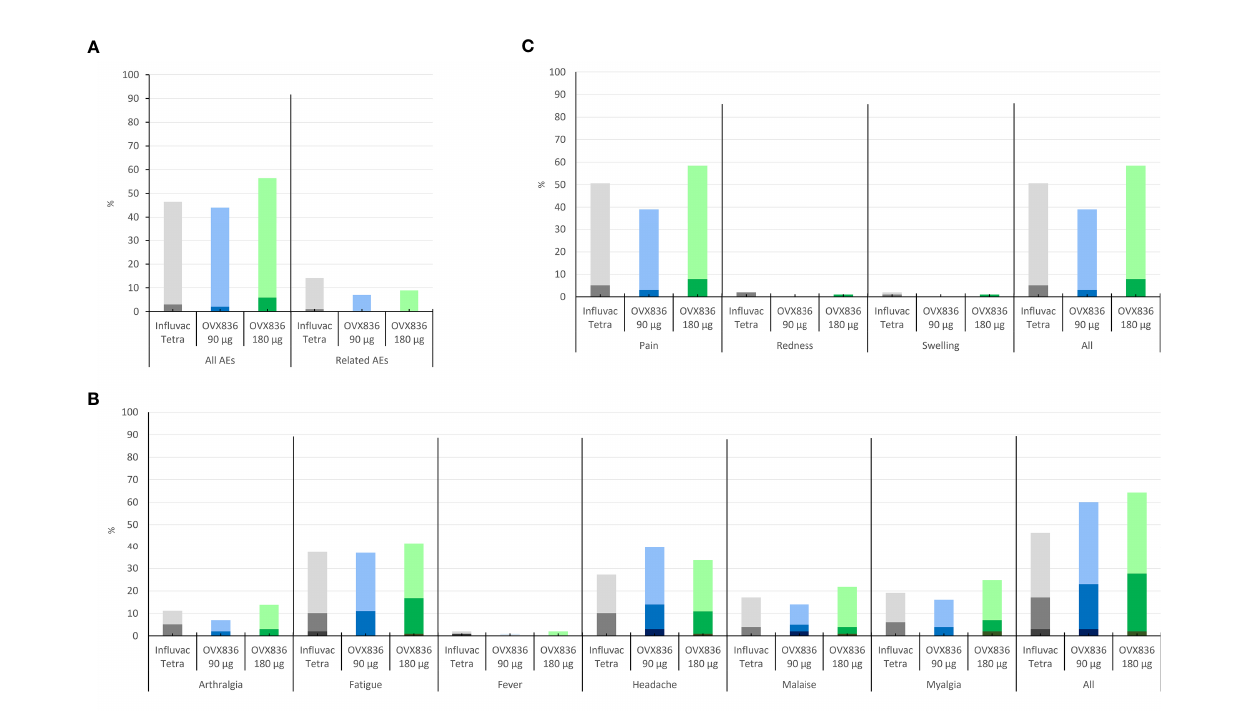
FIGURE 4 | Panel (A) Percentage of subjects reporting mild (light color) or moderate (dark color) solicited local signs during the 7-day post-vaccination period in the three treatment groups (In fl uvac Tetra ™ , OVX836 90µg and OVX836 180µg; modi fi ed intention-to-treat cohort corresponding to the safety cohort). Panel (B) Percentage of subjects reporting mild (light color), moderate (intermediate color) or severe (dark color) solicited systemic symptoms during the 7-day post- vaccination period in the three treatment groups and safety cohort. Panel (C) Percentage of subjects reporting unsolicited adverse events (AEs) (light color) and severe AEs (grade 3; dark color), overall and considered related to the vaccine by the investigator, during the 28-day post-vaccination period, in the three treatment groups and safety